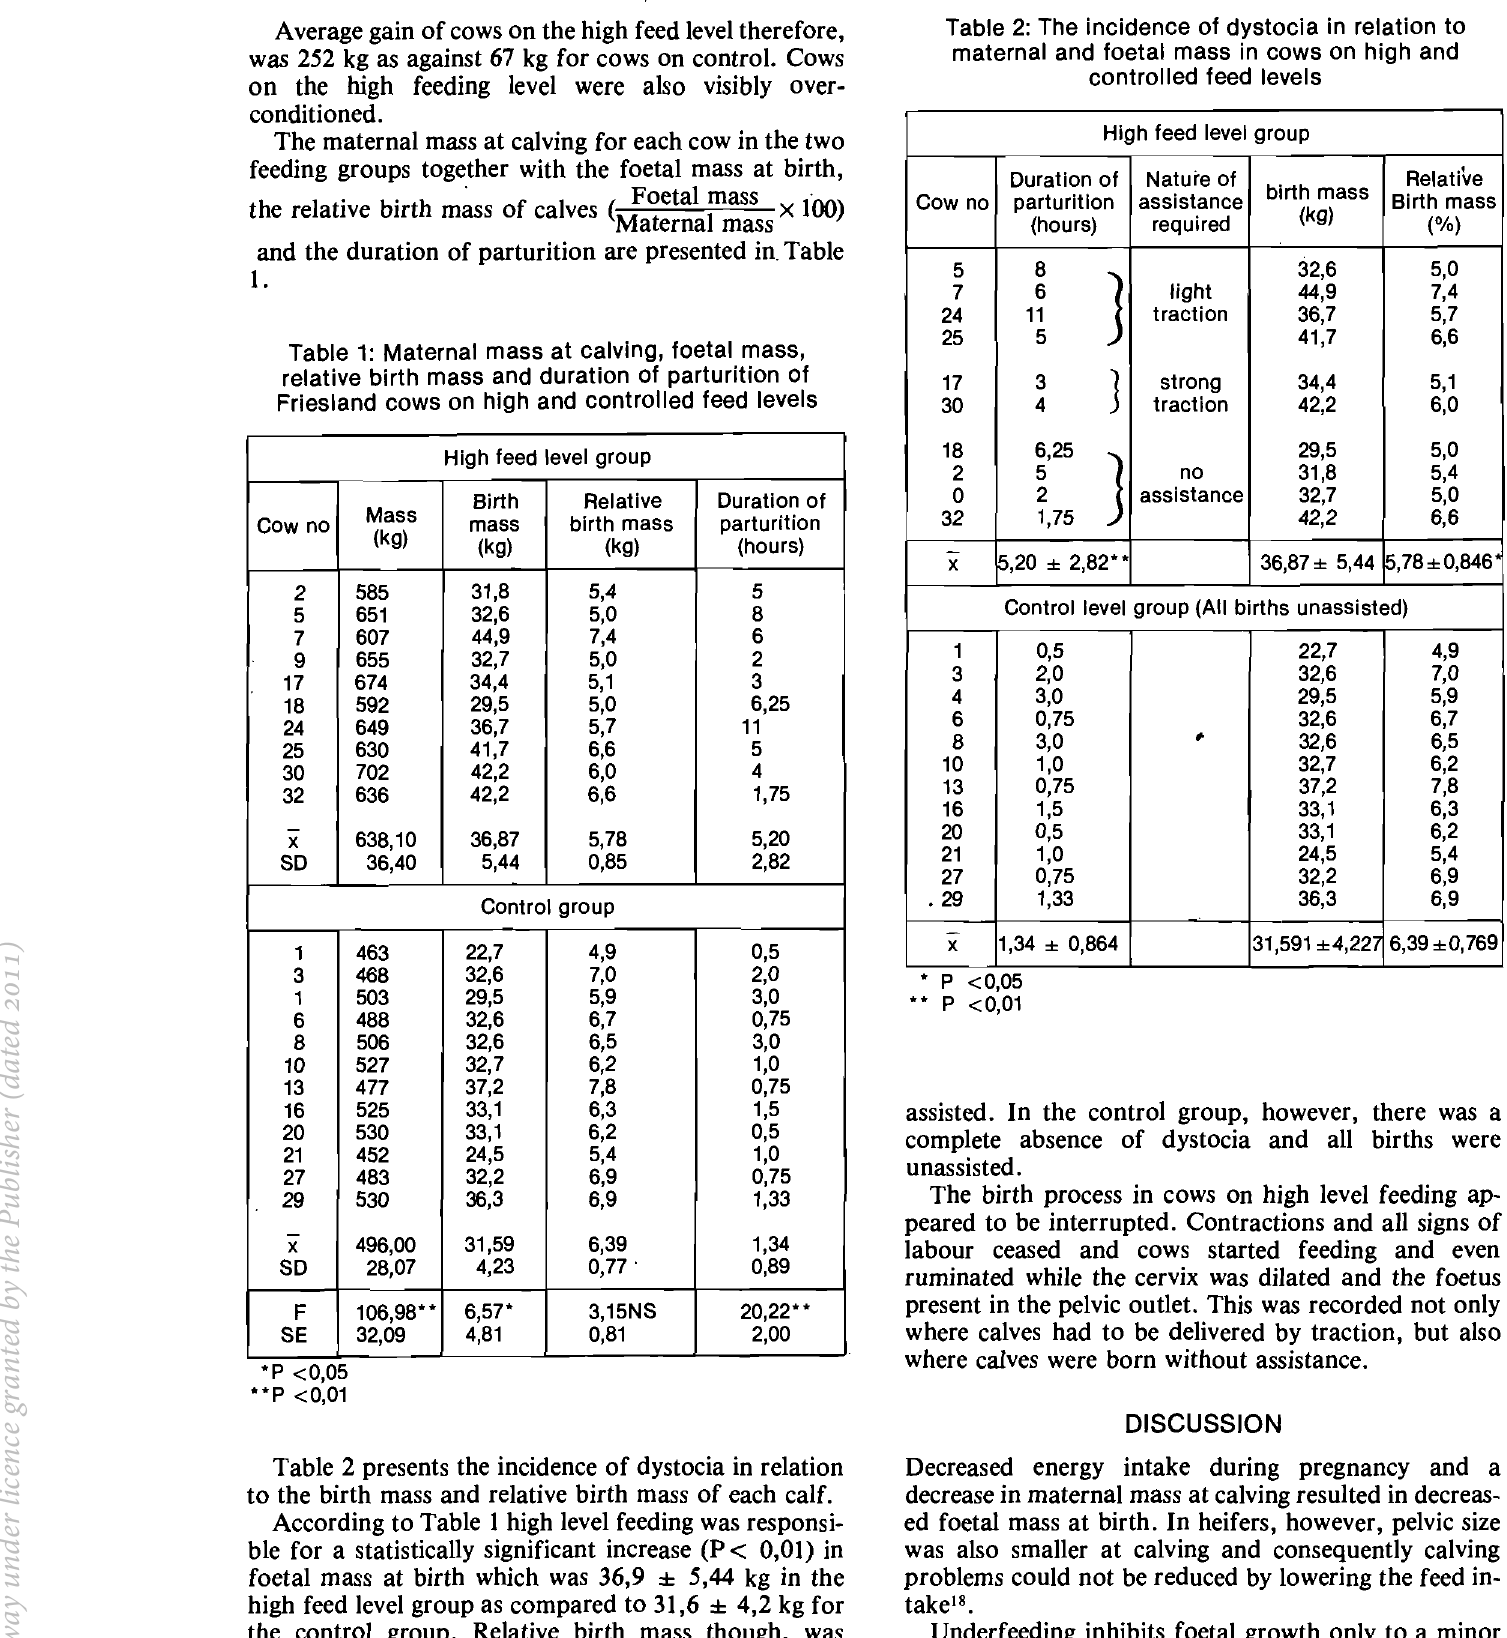
Table 2: The incidence of dystocia in relation to maternal and foetal mass in cows on high and controlled feed